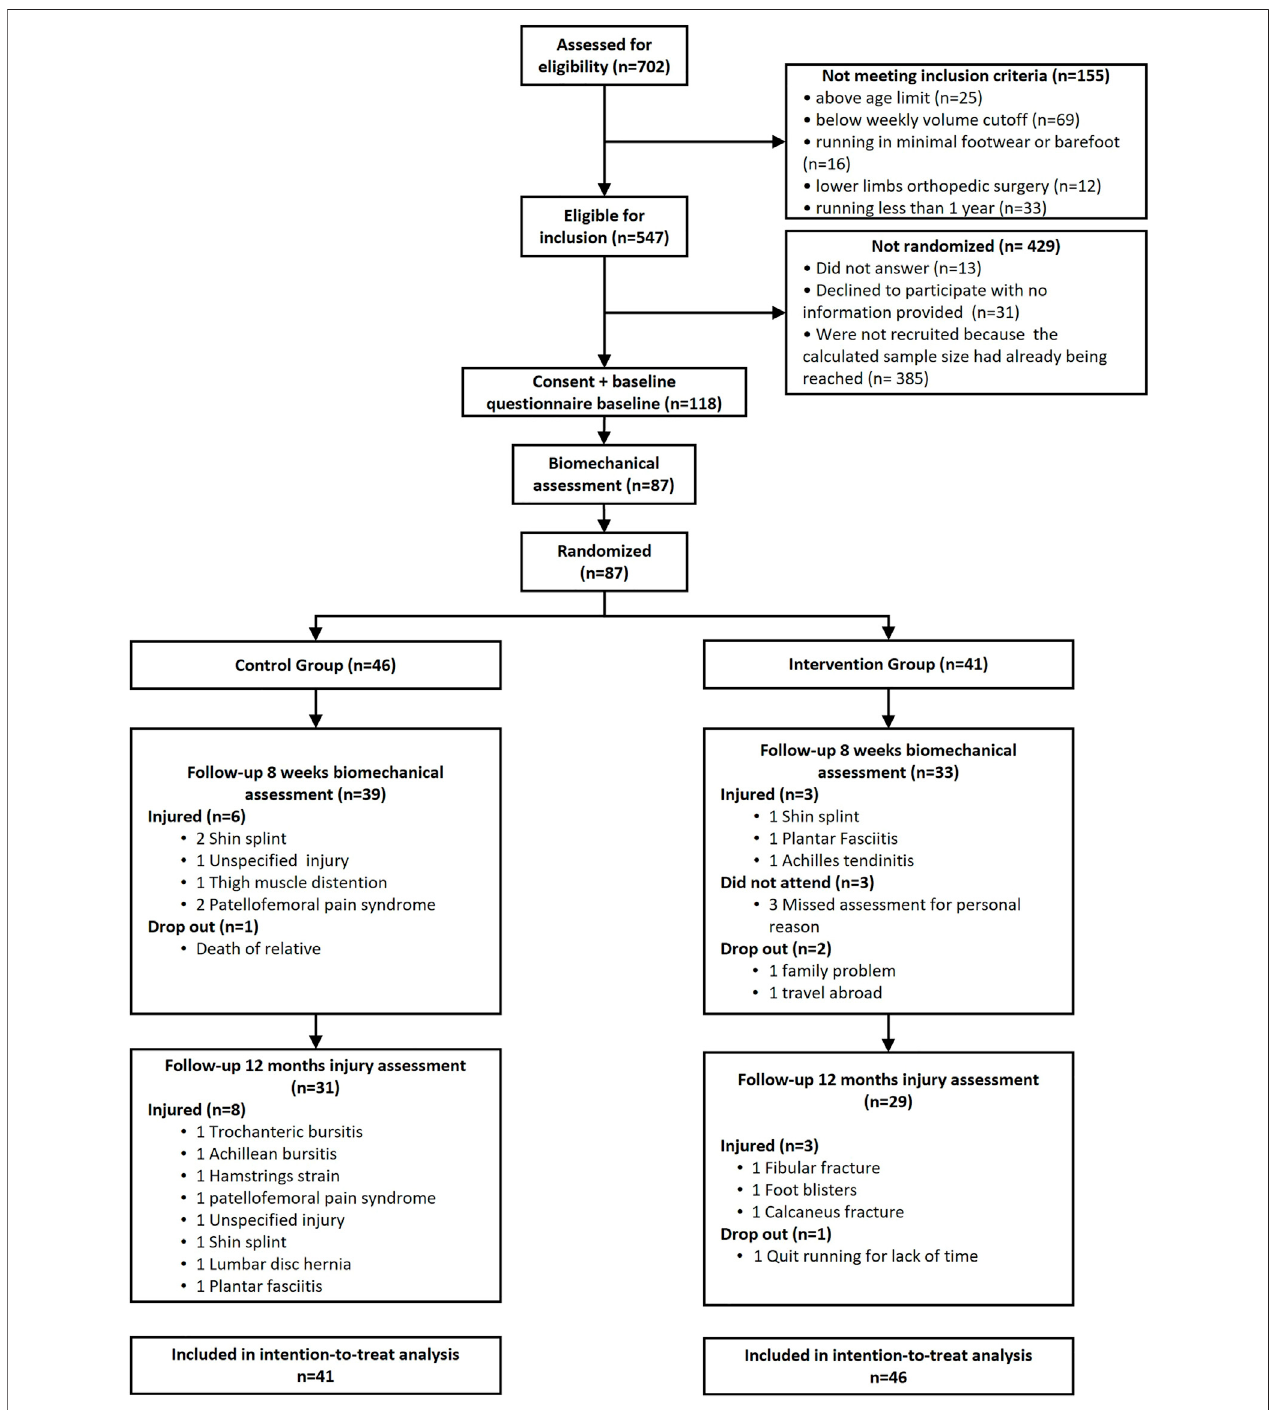
FIGURE 1 | Flowchart of recruitment, assessment, and follow-up